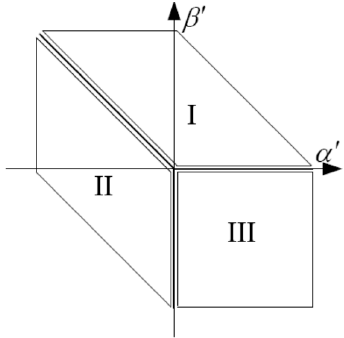
Figure 13. Space vector diagram with three zones.